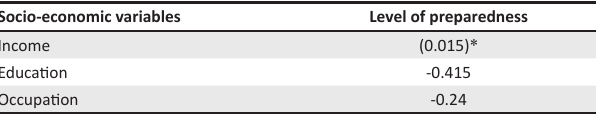
TABLE 5: Results of cross tabulation between level of preparedness and socio- economic